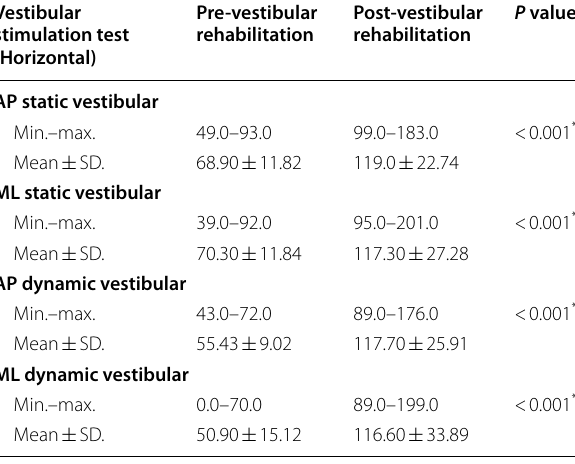
Table 11 Vestibular stimulation test with horizontal head